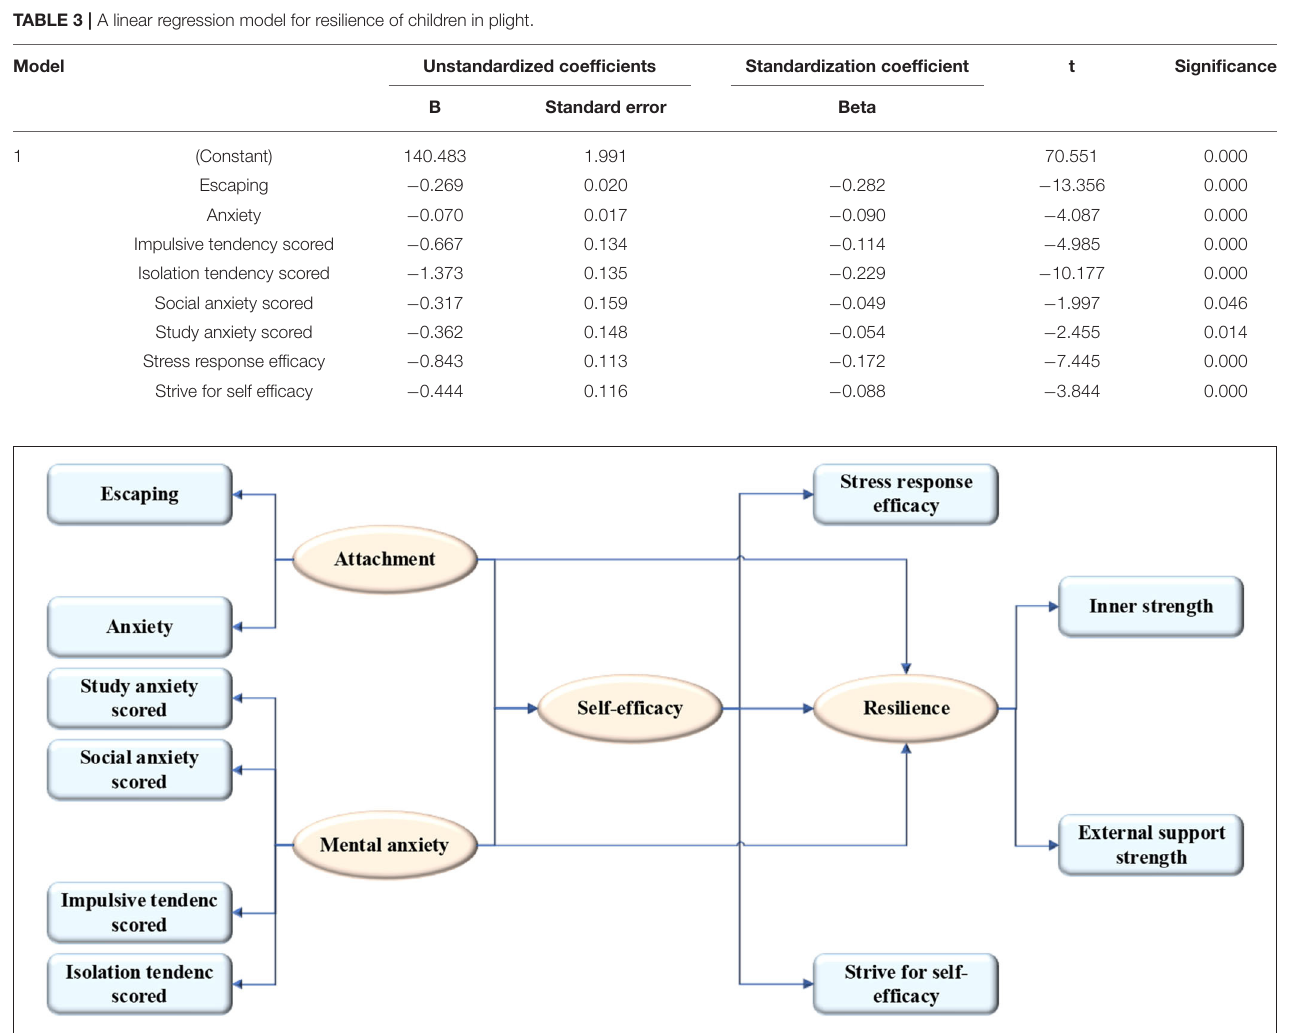
FIGURE 2 | The mediation model of the microstructure of